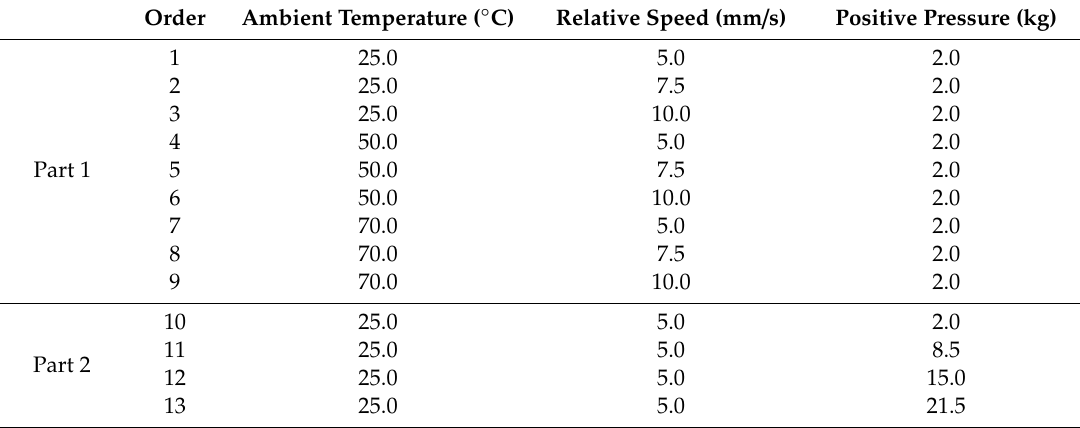
Table 2. Experimental details